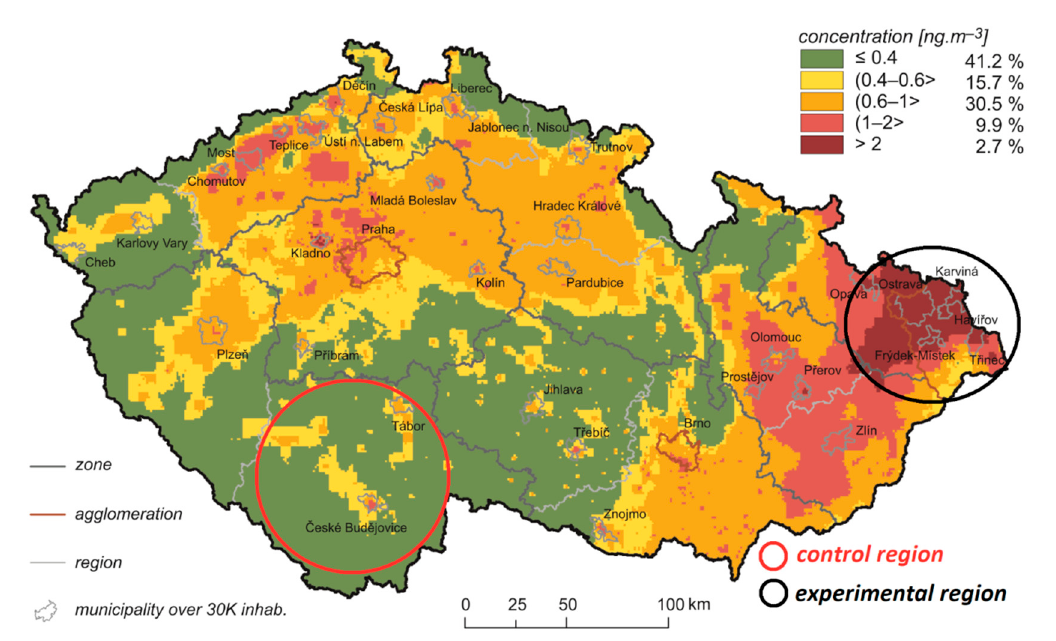
Figure 1. Field of annual average concentration of benzo[a]pyrene for 2018. The figure is modified according to Air Quality Information System—Czech Hydrometeorogical Institute [33].